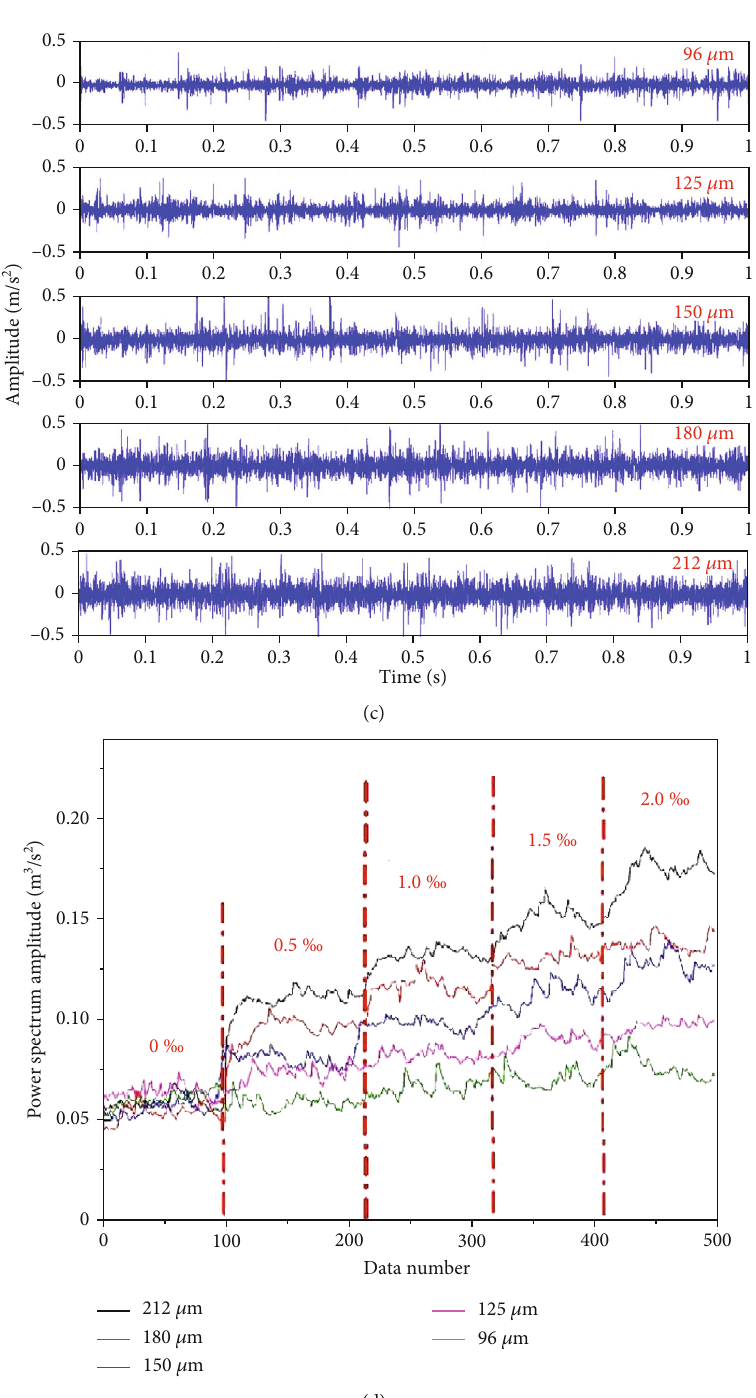
Figure 5: Characteristic analysis of the sand measurement signal under di ff erent fl ow velocity conditions (sand content 1 ‰ , particle size 180 μ m): (a) frequency domain diagram; (b) time spectrum; (c) 30-50 kHz time domain diagram; (d) power spectrum